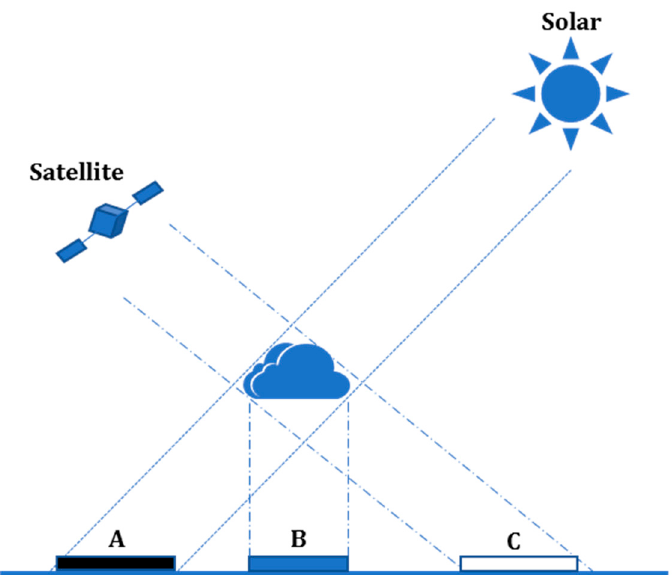
Figure 1. Schematic diagram of solar-cloud-sensor geometry. (A: cloud shadow, B: cloud orthographic position on the ground, C: cloud projection on the image (cloud pixel shown in the image)).